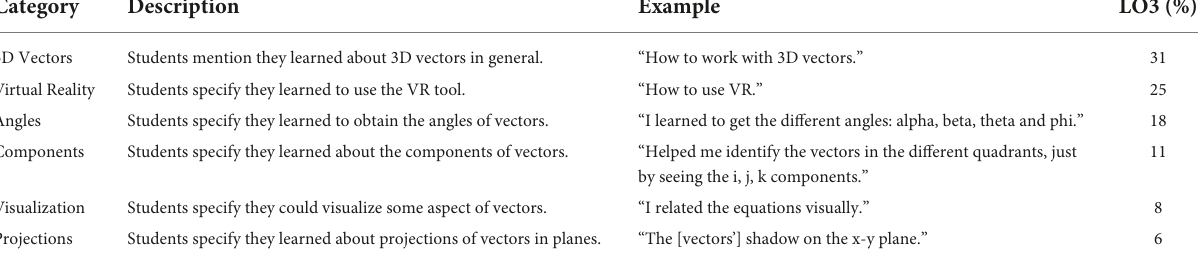
TABLE 5 Description of categories for question